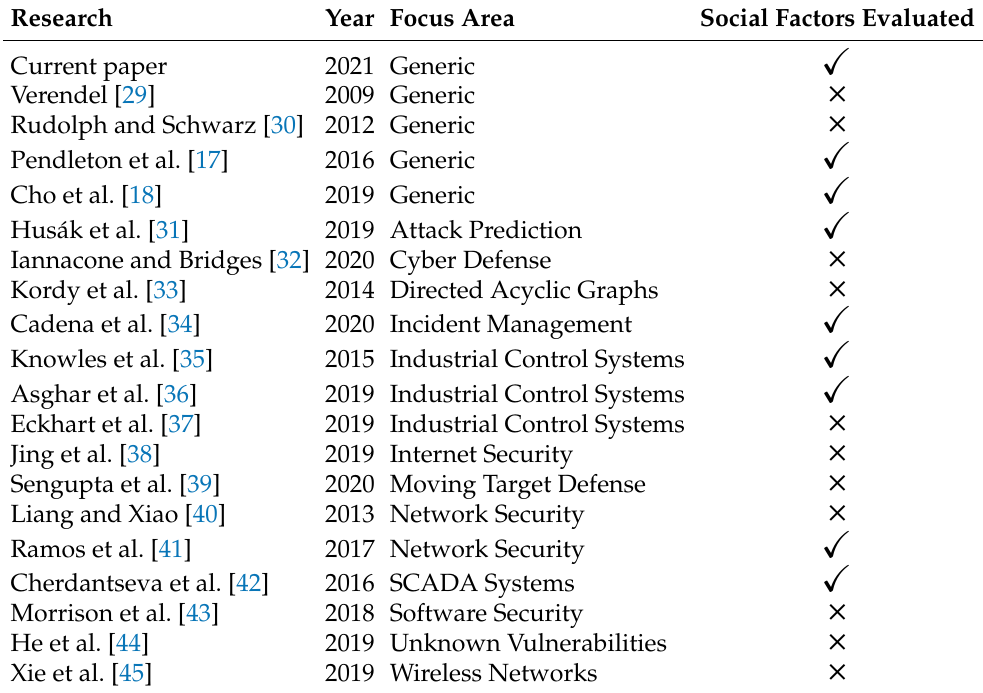
Table 1. Existing cybersecurity metric (systematic) reviews. The research focus area is shown, with “generic” indicating research without a specific focus area. We consider social factors to be evaluated when the review covers socio-technical cybersecurity